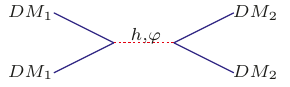
Figure 2. DM conversion via Higgs